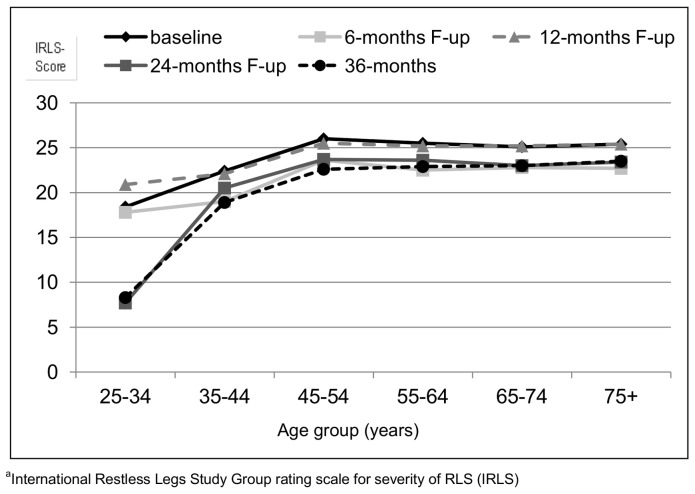
Mean IRLSa score according to six age groups at baseline, 6-, 12- 24- and 36-months follow-up.